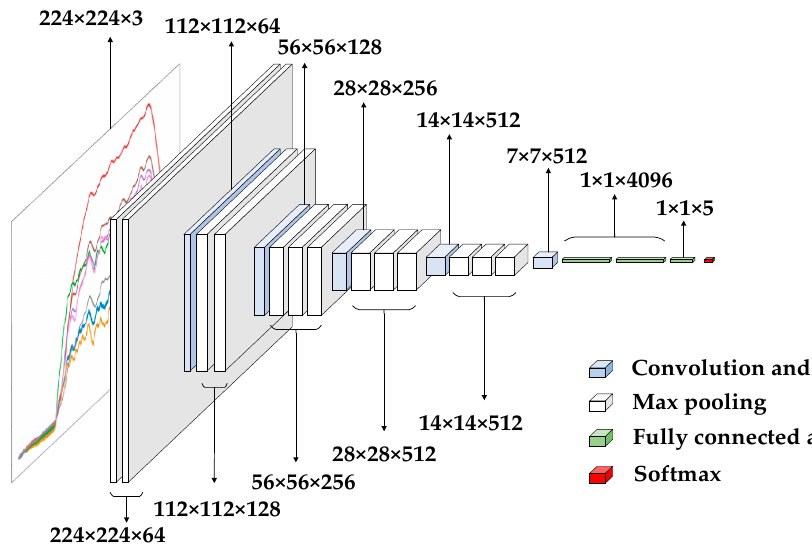
Figure 9. The network architecture of VGG-16.